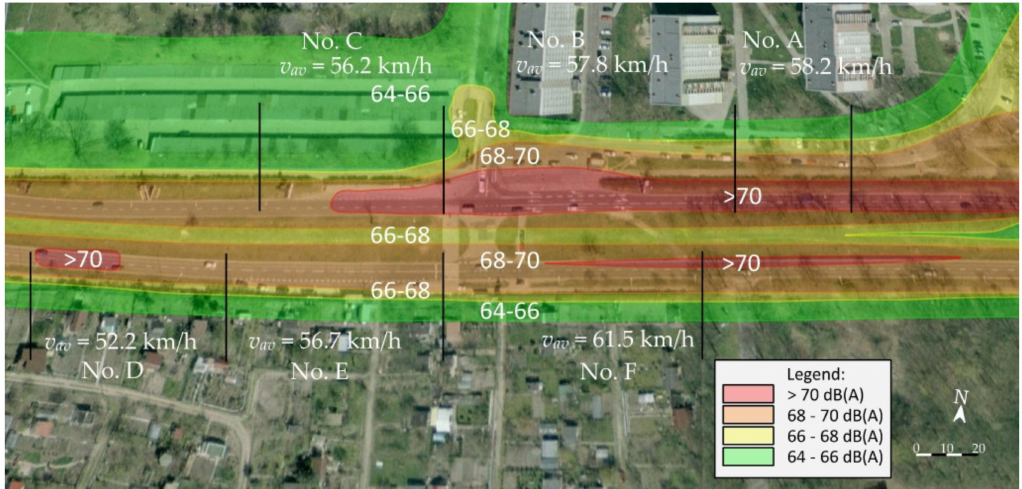
Figure 12. Noise map showing the situation after the implementation of the lane narrowing treatment on the analysed urban dual